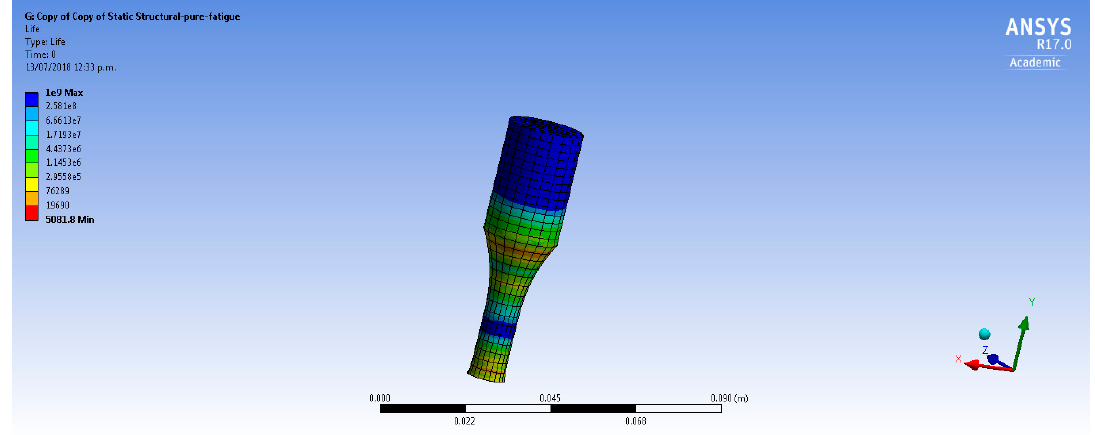
Figure A2. Fatigue life obtained at the creep-fatigue condition using conventional method.